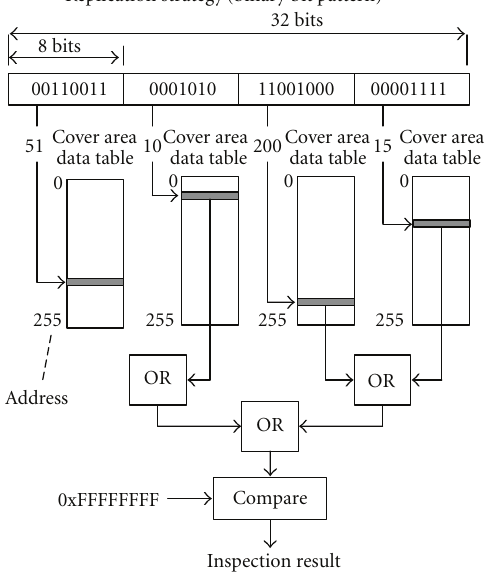
Figure 8: Implementation of the inspection unit on DNA in Figure